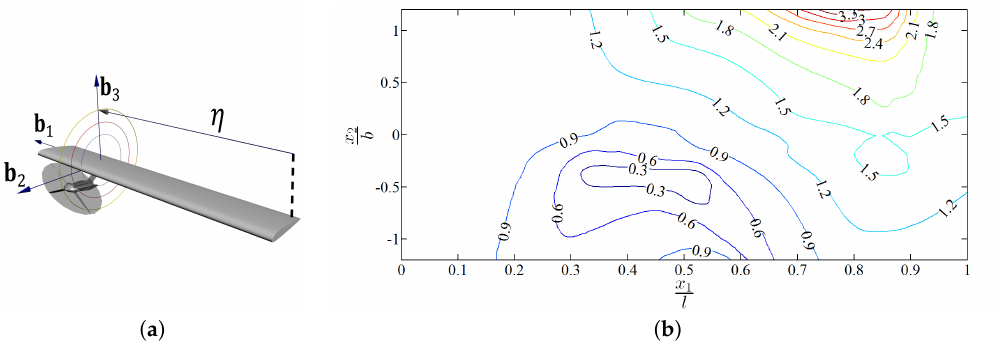
Figure 9. ( a ) Schematic view of the high-aspect-ratio wing with engine; ( b ) Normalized flutter speed contour for different engine locations on b 1 b 2 plane; considering gravity [3]. Reprinted from Mardanpour, P.; Hodges, D.H.; Rezvani, R. Nonlinear aeroelasticity of high-aspect-ratio wings excited by time-dependent thrust. Nonlinear Dyn. 2014 , 75 , 475–500, with the permission of Springer.